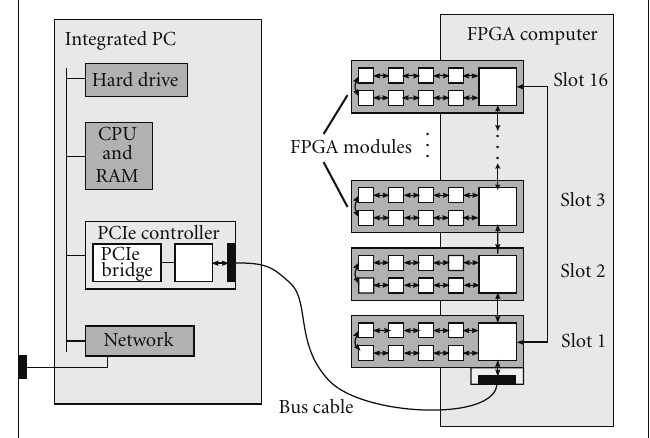
Figure 1: RIVYERA S3-5000 hardware